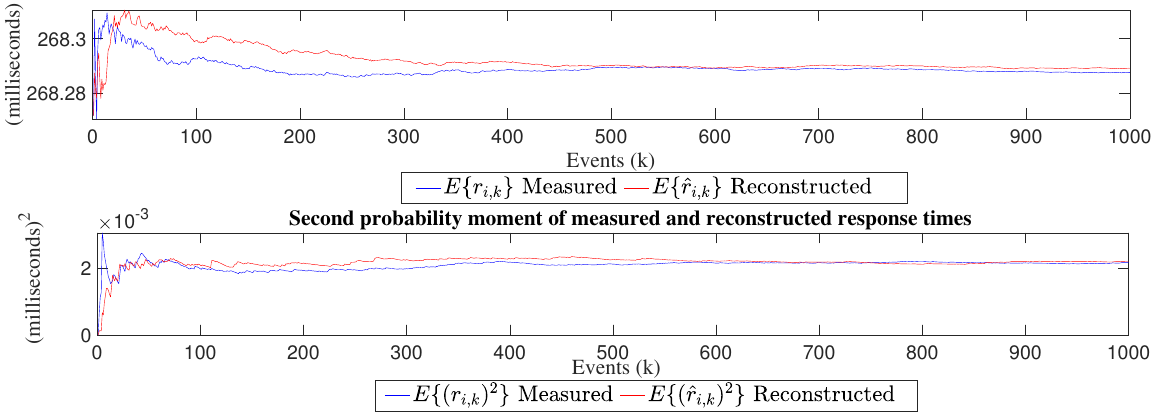
Figure 13. First and second probability moment of reconstructed ˆ r i , k and measured response times r i , k for the 128 × 128 matrix inversion